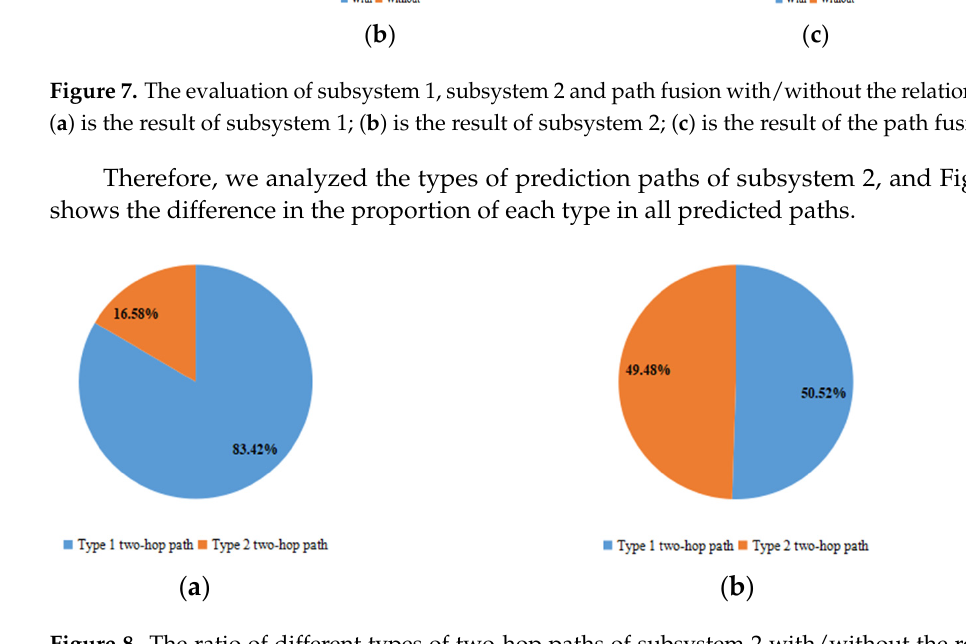
Figure 8. The ratio of different types of two-hop paths of subsystem 2 with/without the relation score. ( a ) is the ratio of two types of two-hop paths in subsystem 2 with the relation score; ( b ) is the ratio of two types of two-hop paths in subsystem 2 without the relation score.